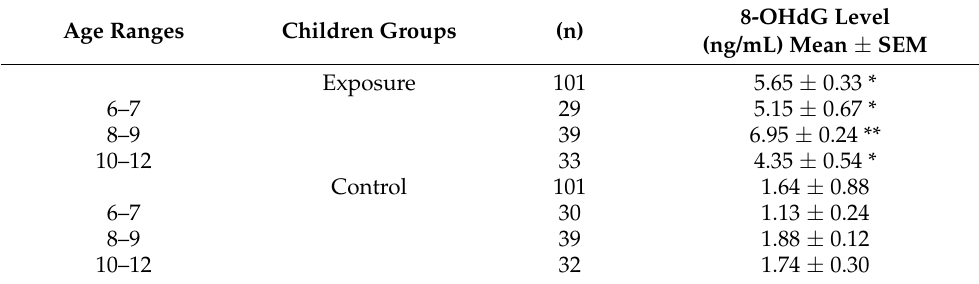
Table 4. Mean of the urinary 8-OHdG levels in the (El Fraile, Taxco de Alarc ó n)-exposure and (Chilpancingo)-control groups in Guerrero State, Mexico.